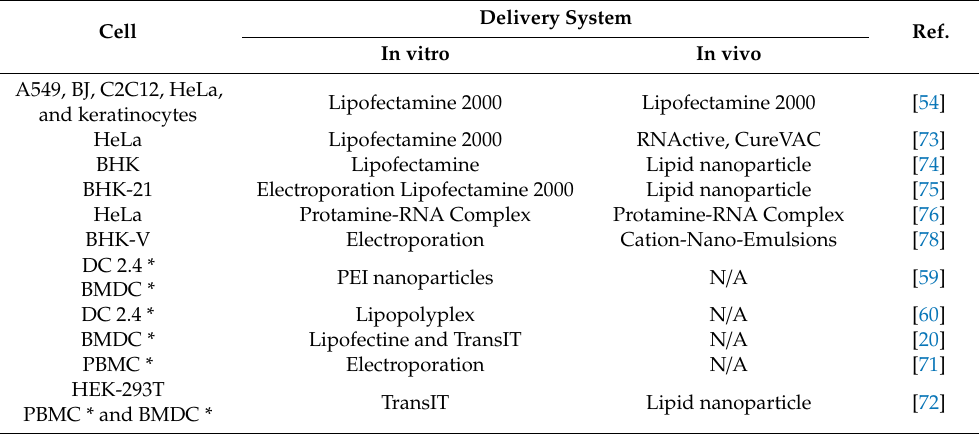
Table 1. Delivery systems for the evaluation of the mRNA